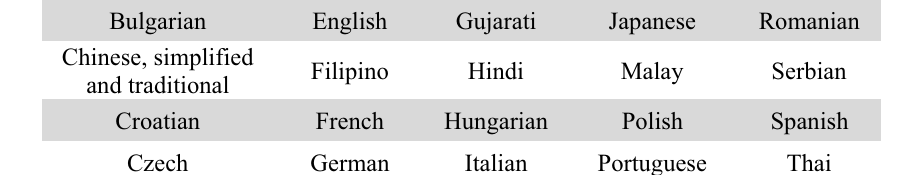
Fig. 3 Countries participating in the ReferID launch and their associated languages. a Map showing countries involved in the launch. b Languages currently available in the ReferID tool.